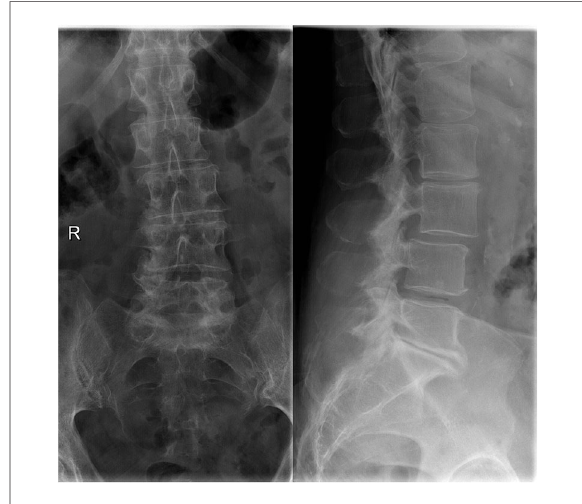
FIGURE 2 Evaluation of lumbar spine motion with dynamic x-ray prior to index surgery: fl exion view (left) and extension view